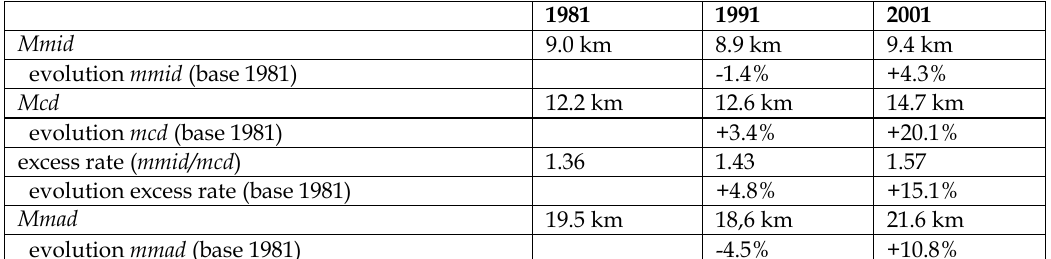
Table 2. Evolution of the global minimum commuting distance and excess rate 1981 1991